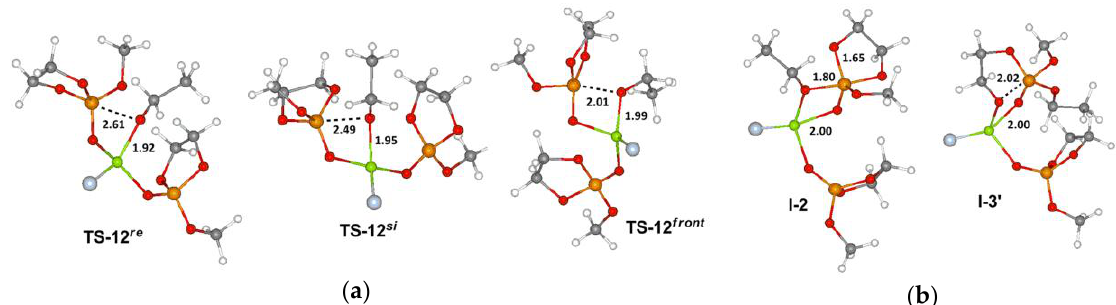
Figure 1. ( a ) Geometries of apical ( re - and si -), and frontal transition states MTS-12 ; ( b ) Geometries of intermediates MI-2 and MI-3 (DBP fragments are omitted for clarity, DBP oxygen atoms are marked in blue).